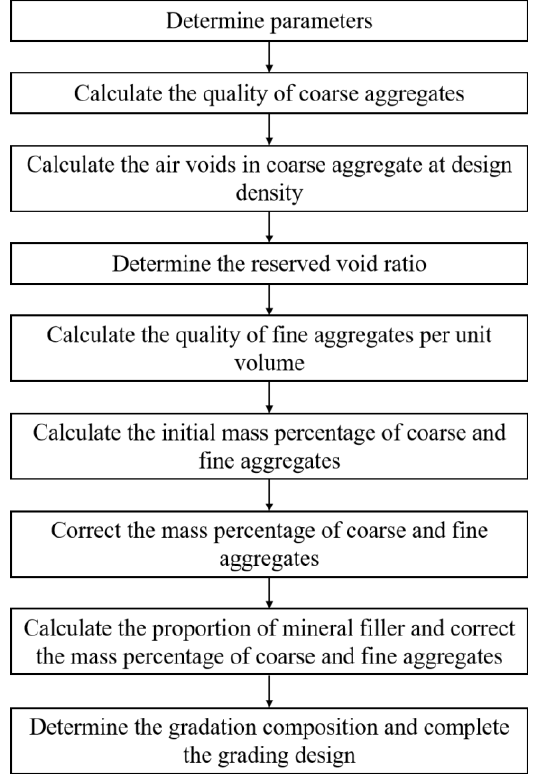
Figure 3. Process of design of aggregate composition.